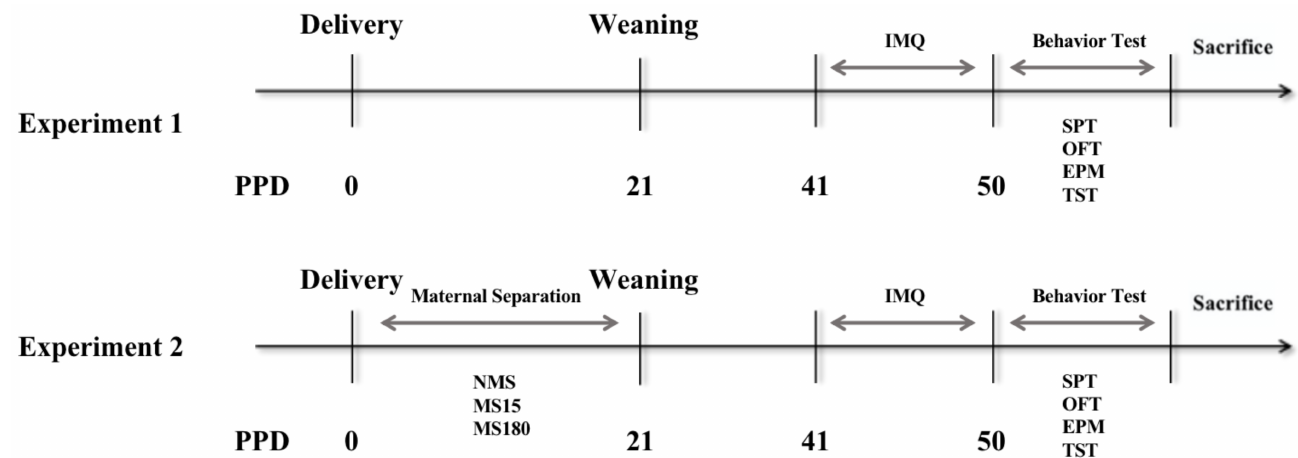
Figure 1. Experimental procedures. Experience 1: Female mice with no MS had imiquimod cream applied for 8 days consecutively. Experience 2: Female offspring were subjected to different PS protocols during lactation and then had imiquimod cream applied after adulthood. PPD, postpartum day; OFT, open field test; EPM, elevated plus maze; SPT, sucrose preference test; TST, tailed suspension